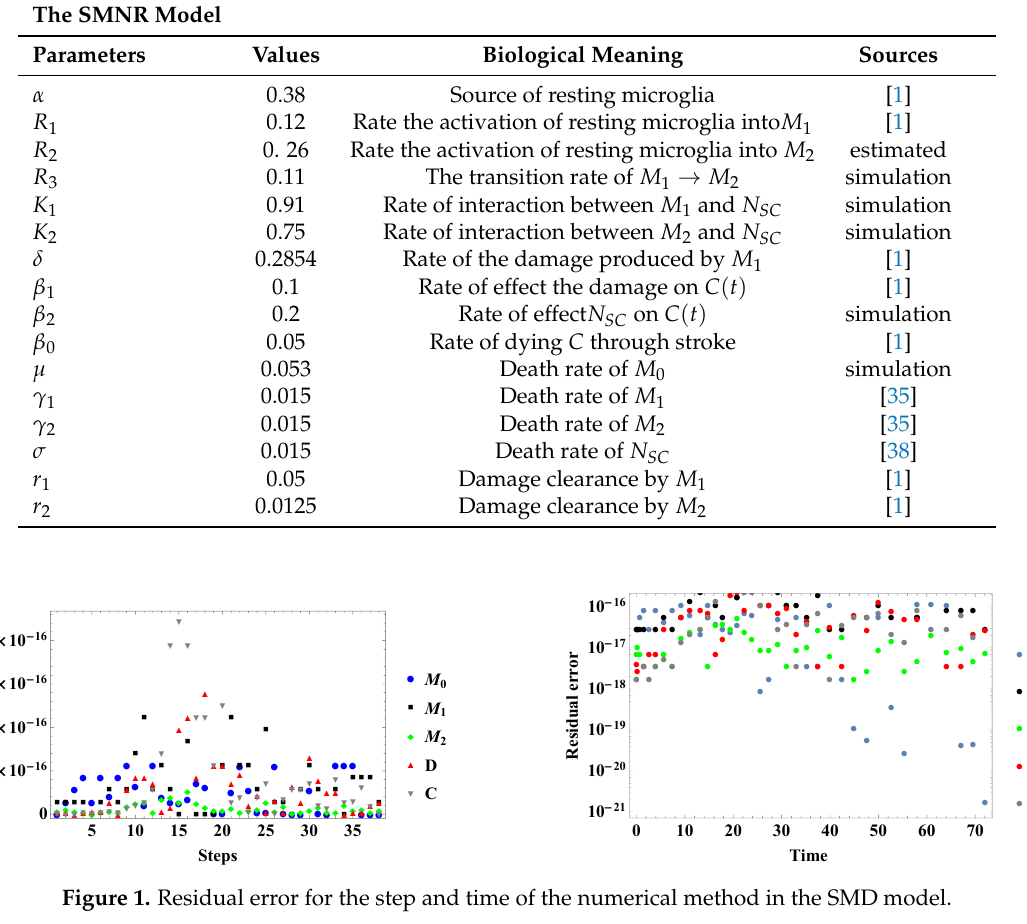
Figure 1. Residual error for the step and time of the numerical method in the SMD model.